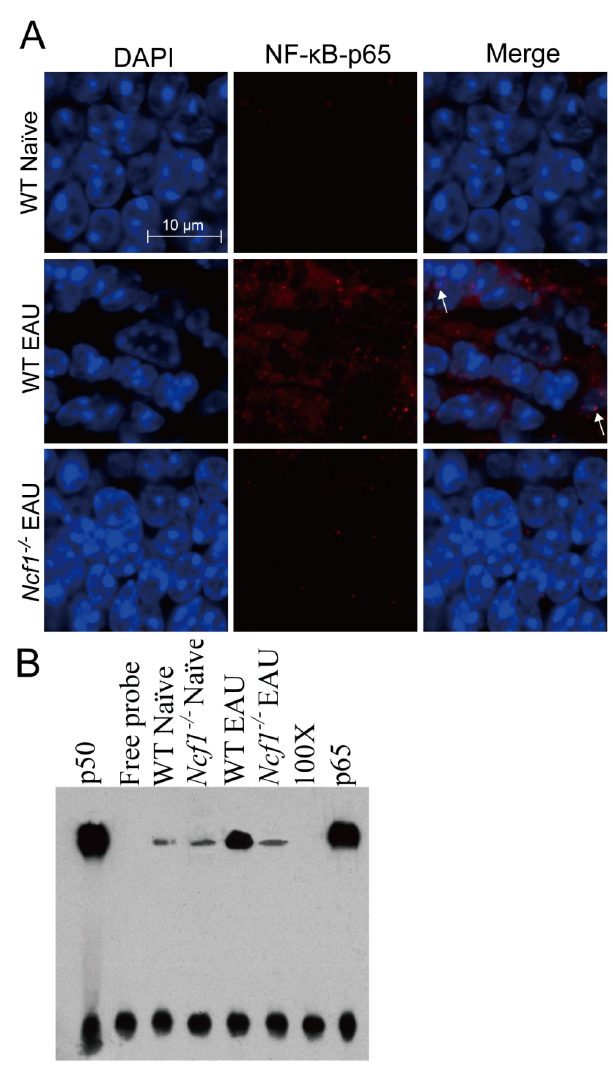
Figure 4. Absence of Ncf1 reduces NF- κ B activation in the retinas of mice with EAU induction. Eyes and retinas of wild-type (WT) and Ncf1 − / − mice without (naïve) or with EAU induction were subjected to immunofluorescence staining with DAPI for nuclei and with antibody for NF- κ B (p65) ( A ) and to electrophoretic mobility shift assay (EMSA) ( B ). In panel A, the outer nuclear layer of the retina is shown. Images are representative of at least four samples per group from two independent experiments. Arrows indicate NF- κ B in the nucleus. In panel B, lane 1: p50 subunit of NF- κ B; lane 2: free probe; lane 3: wild-type naïve mice; lane 4: Ncf1 − / − naïve mice; lane 5: wild-type EAU mice; lane 6: Ncf1 − / − EAU mice; lane 7: 100-fold molar excess of unlabeled NF- κ B probe. Lane 8: biotinylated probe with anti-p65 antibody. Top bands are the complexes of p50 / p65 / biotin-labeled DNA probe and bottom bands are free